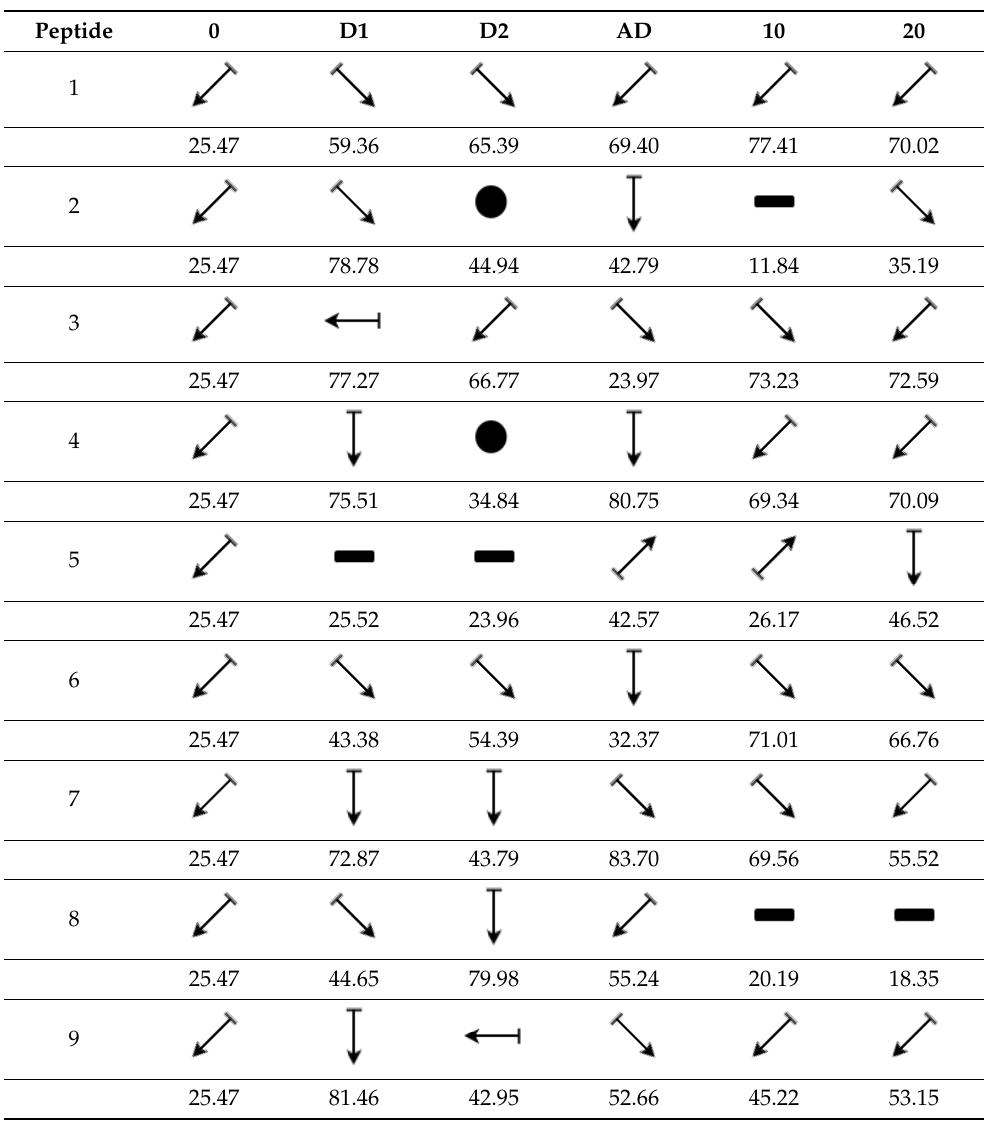
Table 3. Peptide amino acids in contact with the silica surface at the end of the adsorption simula- tion. The percentage of each peptide’s amino acids in contact with the surface is shown in the final column. Peptide